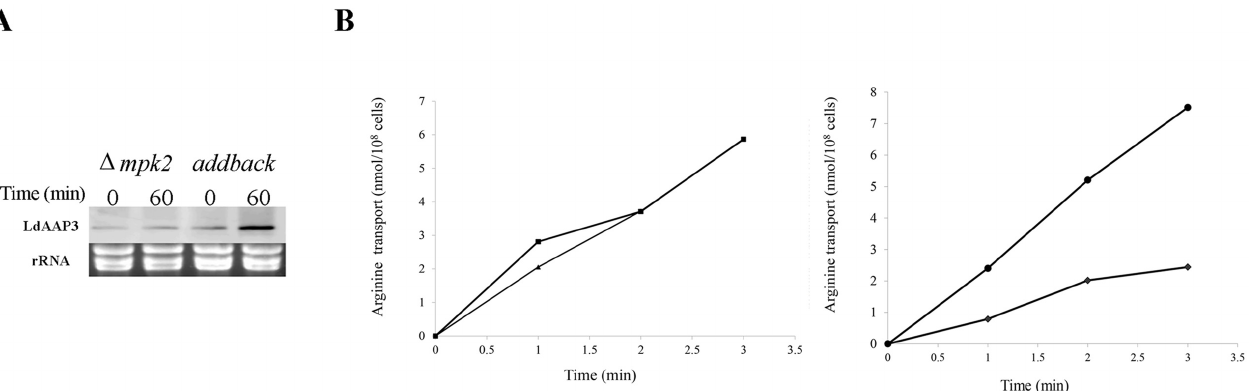
Fig 5. Arginine deprivation response is mediated by MPK2. Promastigotes of L . mexicana mutants lacking both copies of the MPK2 gene ( Δ mpk2 ) and those containing a single wild type copy of the gene re-inserted into their genome (addback) were subjected to 2 hours arginine deprivation as described in Fig 1. A) Northern analysis of total mRNA from these cells using LmxMPK2 probe. B) Arginine transport was measured for Δ lmxmpk2 (left panel) and addback (right panel) cells grown in the presence ( ♦ ) or absence ( (cid:129) ) of arginine.